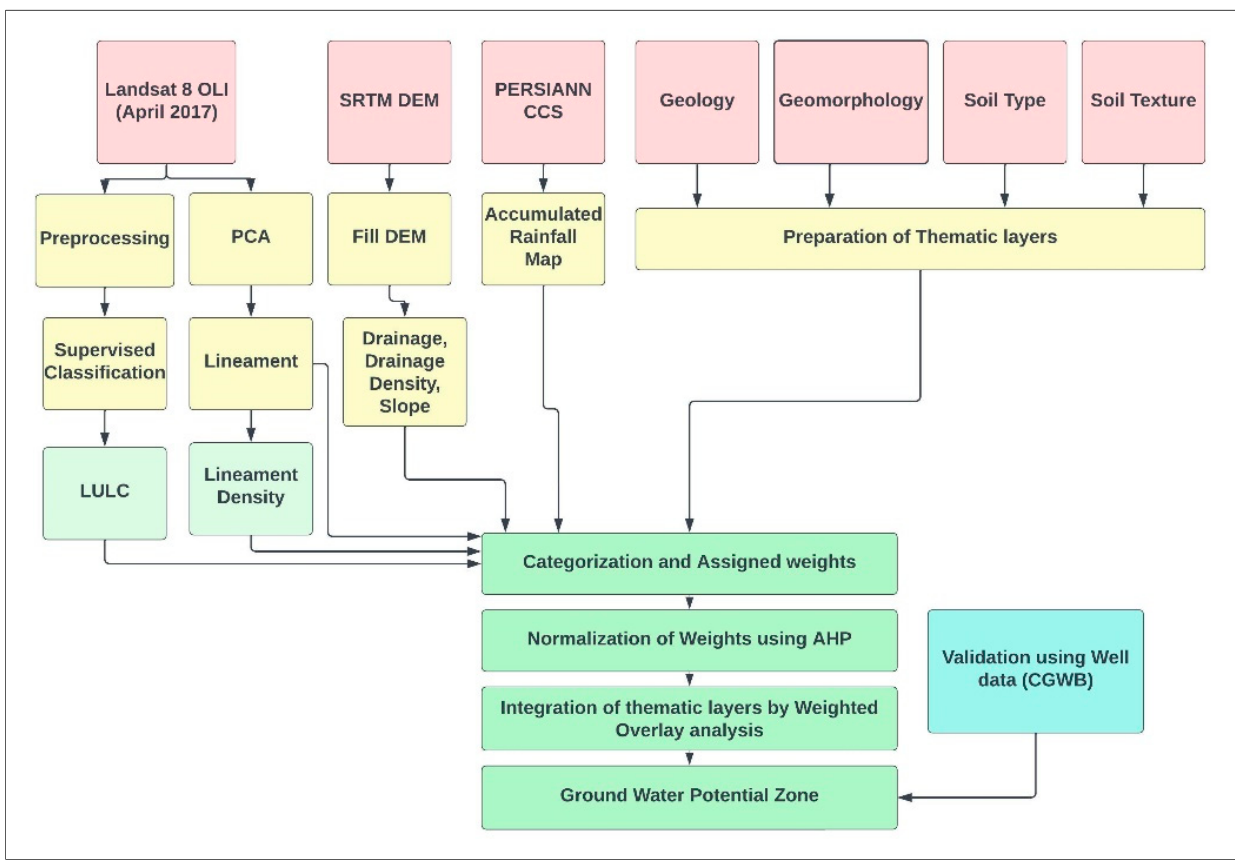
Figure 13. Methodology adopted.